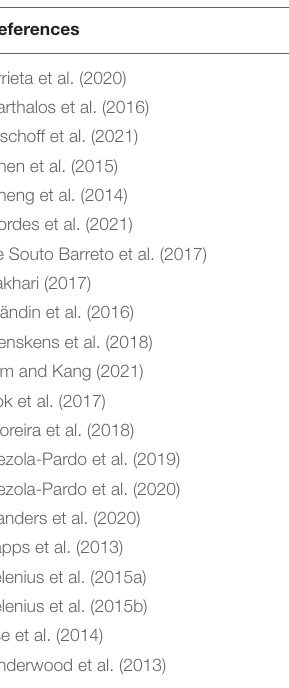
TABLE 1 | Assessment of the methodological quality of the